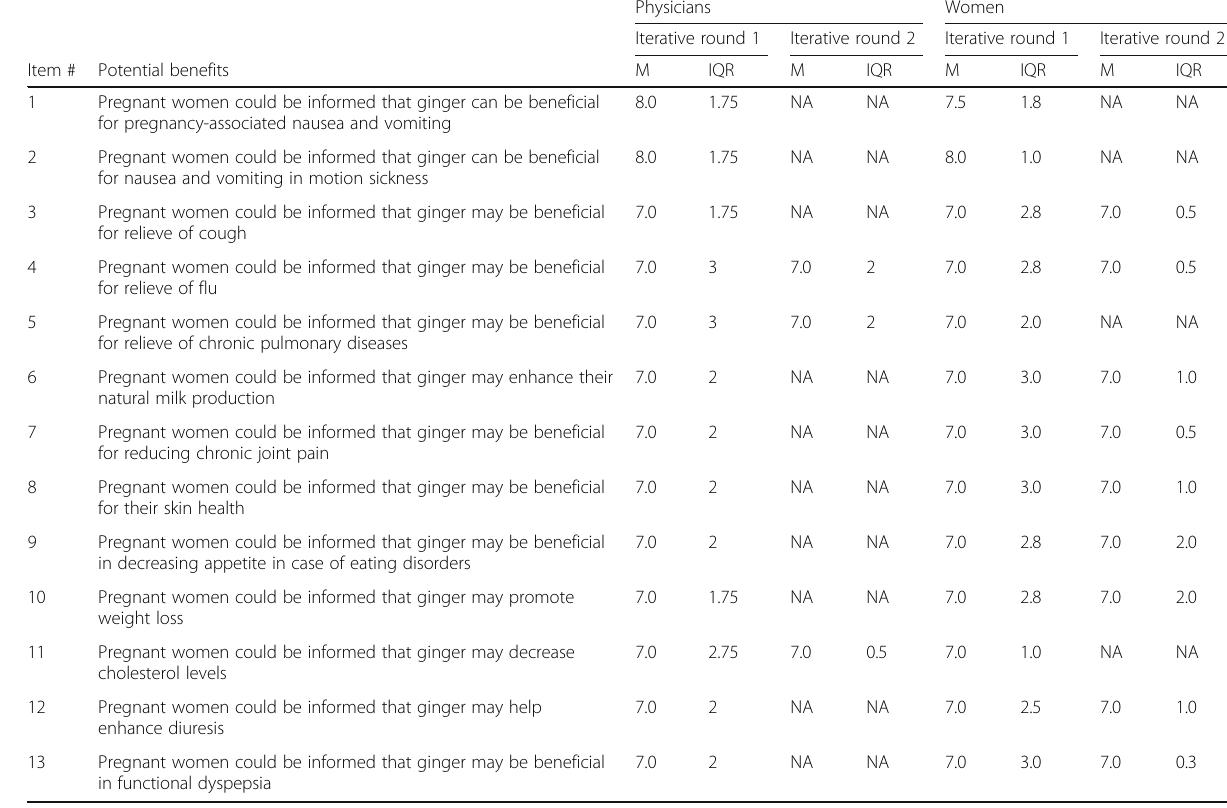
Table 4 Important potential benefits of using ginger for the management of NVP to be addressed during the clinical consultation Physicians Women Iterative round 1 Iterative round 2 Iterative round 1 Iterative round